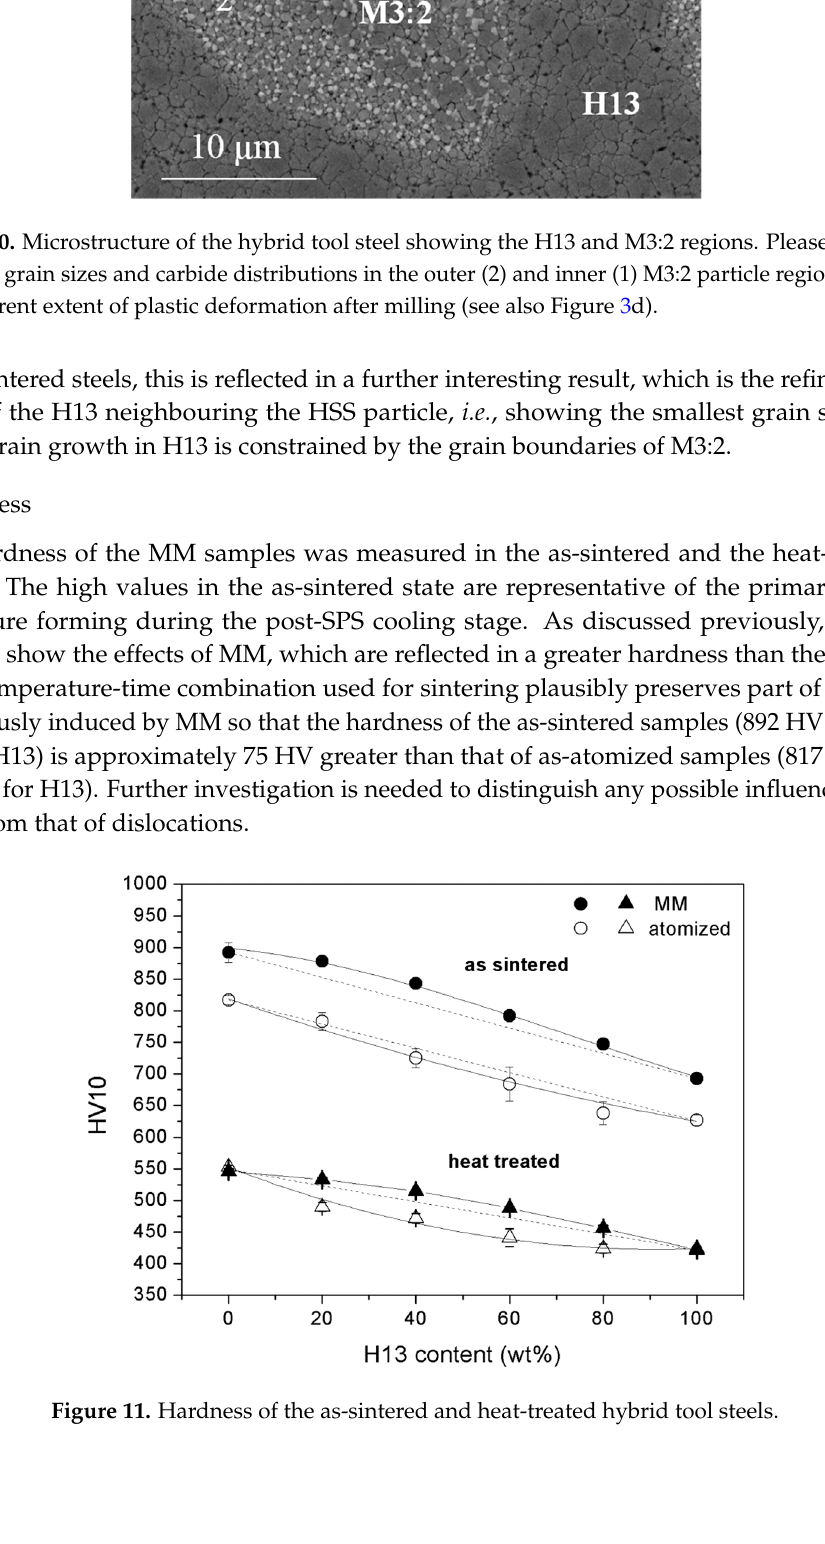
Figure 9. X-ray diffraction pattern for sintered M3:2.